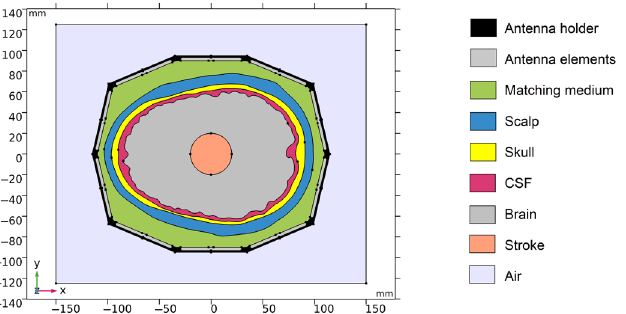
Figure 1. Geometry of the 2D numerical model. Antenna holder and antenna elements surrounding a realistic human head model. XY-plane corresponds to the cross-section at z = 100 mm of the laboratory prototype 3D numerical model.